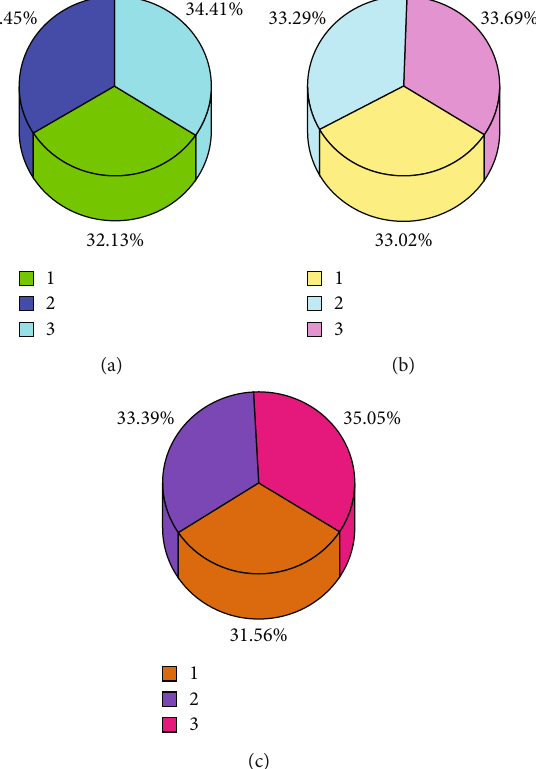
Figure 7: Carbon fi ber contributions of mechanical properties: (a) tensile; (b) fl exural; (c) impact